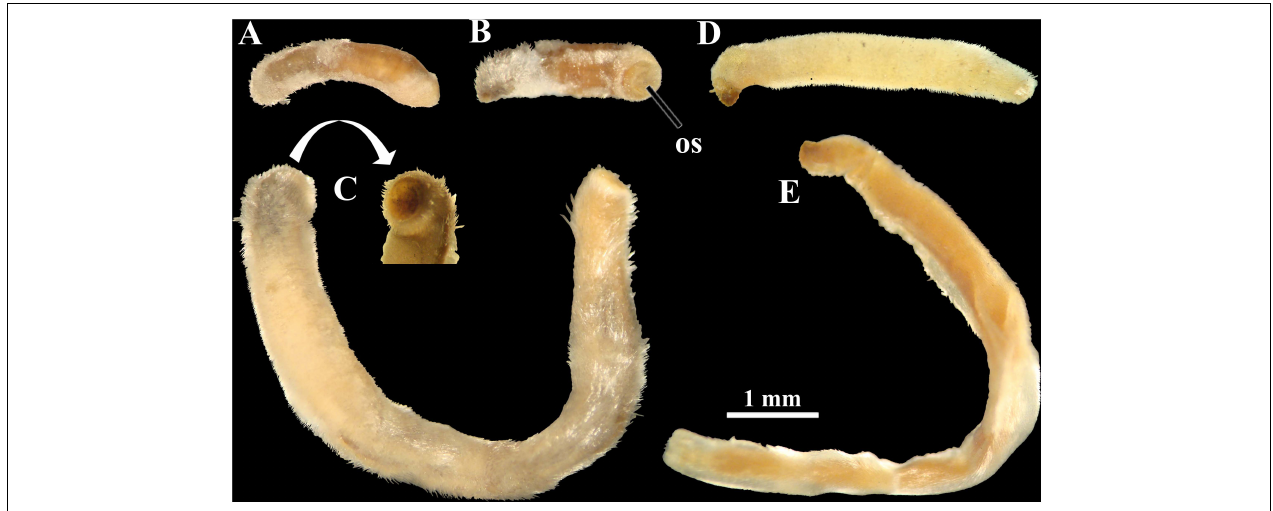
FIGURE 8 | Photomicrographs under stereomicroscope of examined lots of Scutopus megaradulatus (A–D) and S. chilensis (E). (A–C) , AMNH 265347: this lot contains two tubes, one with the anteriormost body part [ (A) , (B) , in right lateral and ventral views, respectively; the oral shield is visible in (B) ], and another with a dissected specimen (C) which has its anterior end missing (viewed in detail); note that this latter specimens is the same as the one illustrated by Salvini-Plawen (1972: fig. 21) (although he photographed it from the opposite left side). (D) , AMNH 265348, a fragment of the trunk (probably from the midgut region), shown from the left side. (E) , AMNH 265349, viewed from the left side. All in same scale. os - oral